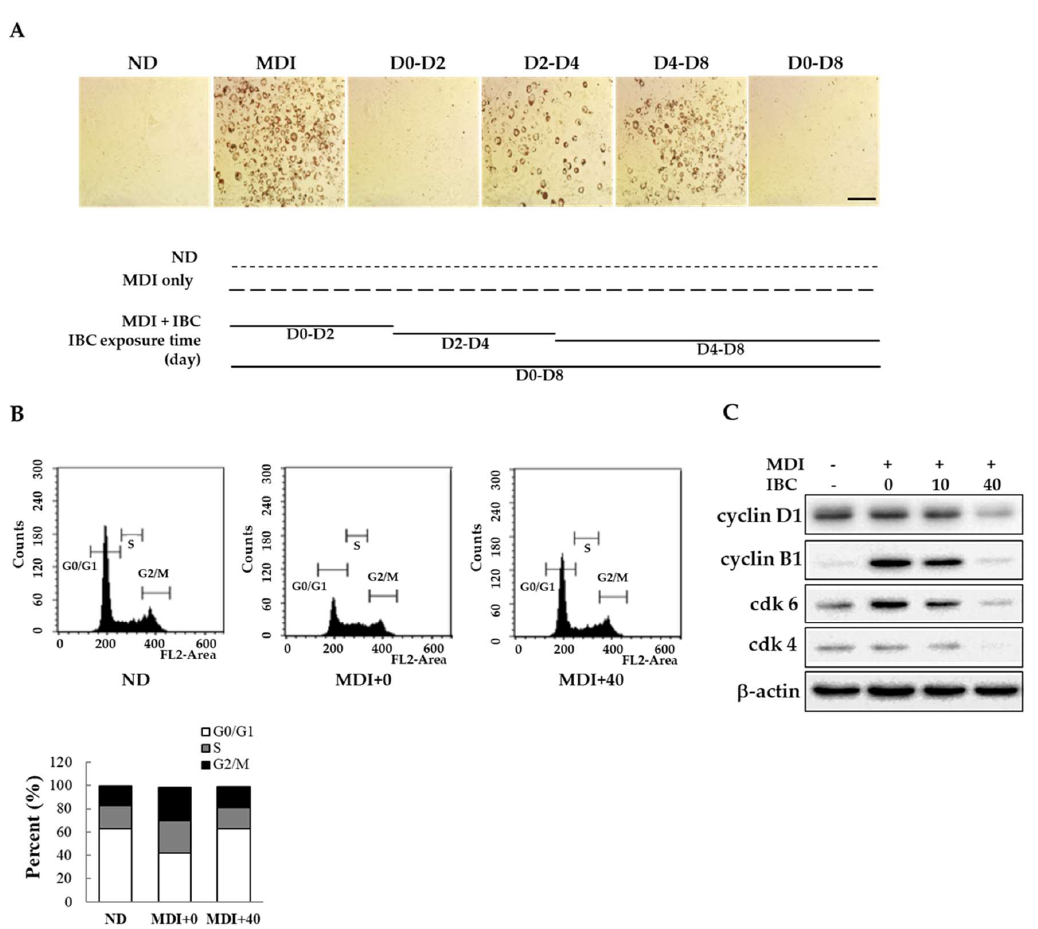
Figure 2. Inhibitory effect of IBC on mitotic clonal expansion. ( A ) Confluent 3T3-L1 preadipocytes were differentiated with MDI to induce differentiation in the presence or absence of IBC (40 µ M). Cells were exposed to IBC during indicated differentiation periods. On D8, all groups were simultaneously subjected to ORO staining. ND, not-differentiated; MDI, differentiation medium. Scale bar = 100 µ m; ( B ) Differentiation initiated adipocytes (D0) were treated with IBC for 48 h followed by flow cytometry; and ( C ) Cell lysates were prepared for Western blotting using indicated antibodies as described in Materials and